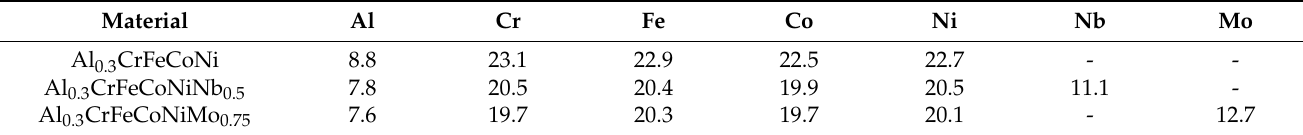
Table 1. Chemical composition of the gas-atomized powder in at.%.